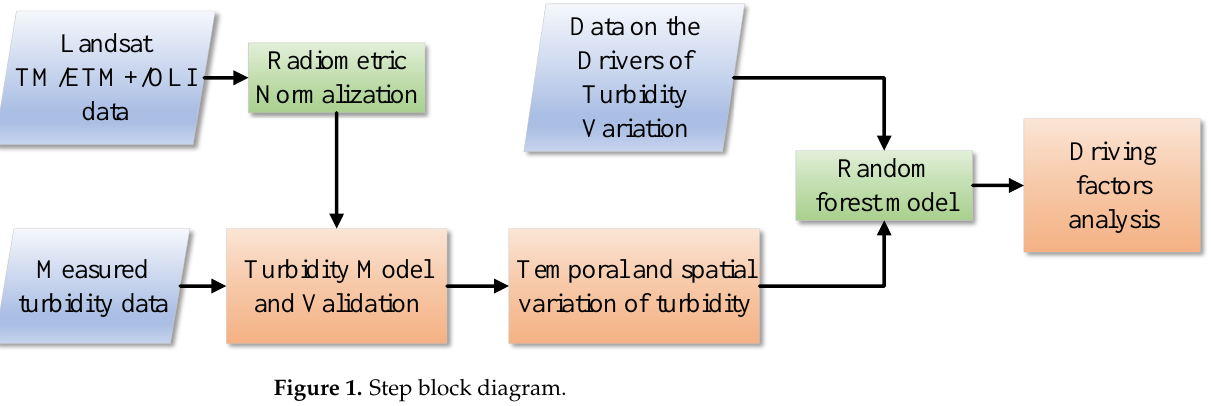
Figure 1. Step block diagram.